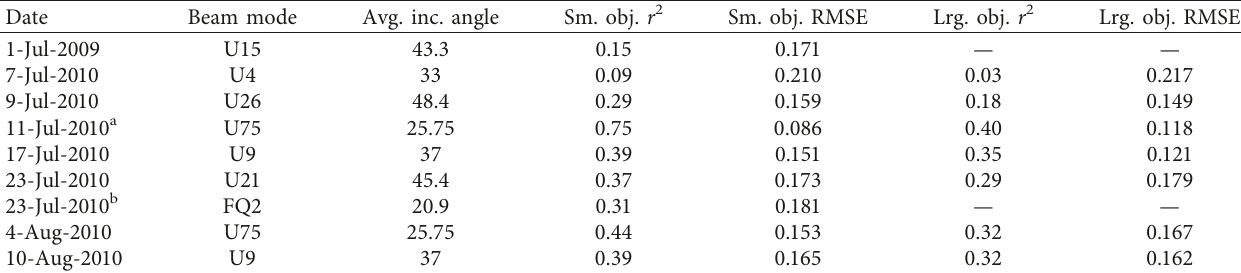
Table 3: r 2 and RMSE values of the ANN applied to the different scenes/dates at the CBAWO in 2010. Date Beam mode